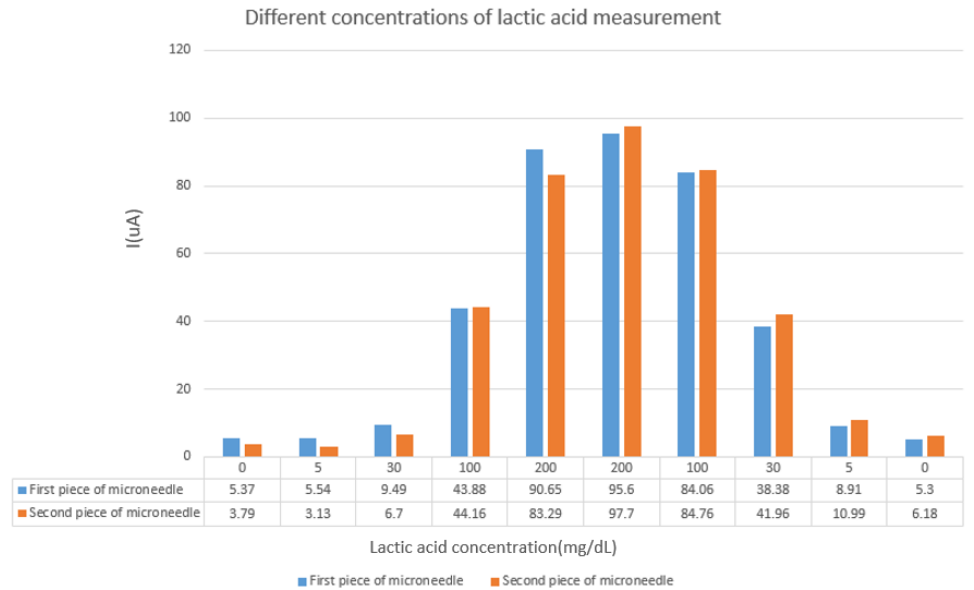
Figure 14. The measurement results with different lactate concentrations on the x-axis and the corresponding currents (µA) on the y-axis.